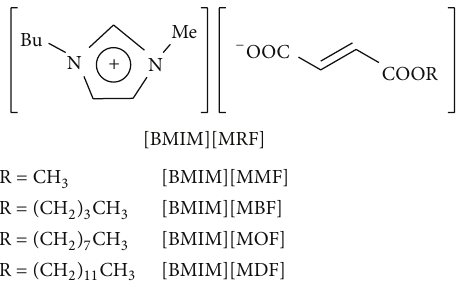
Scheme 1: The structure of ILs with fumarate